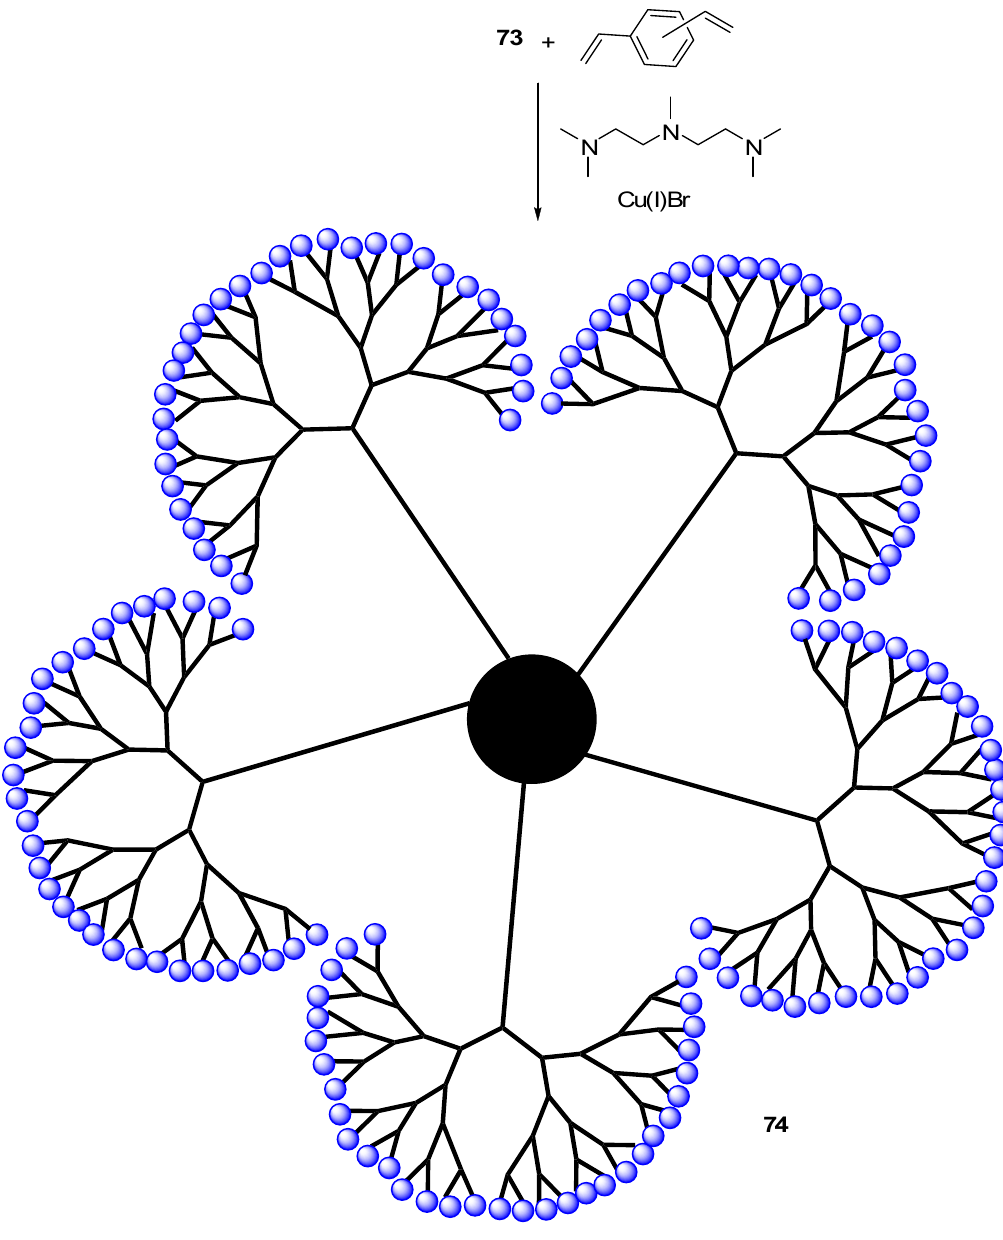
Scheme 37. Preparation of a fifth generation functionalized core cross-linked star (CCS) polymers via the “Arm First” approach